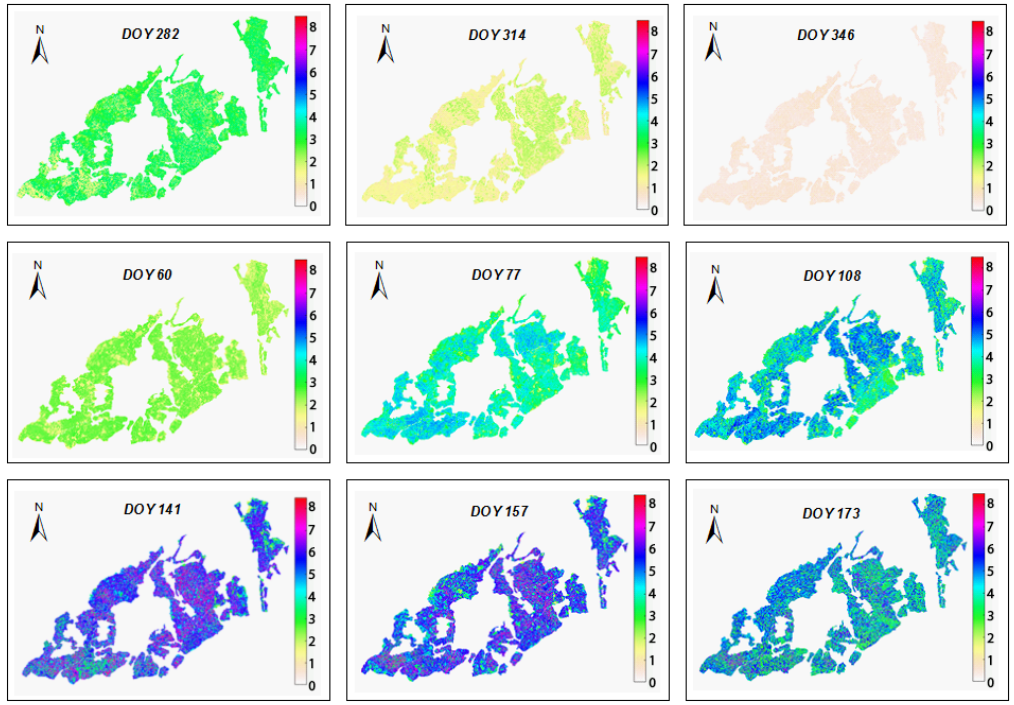
Figure 8. Doukkala irrigation scheme: actual daily evapotranspiration ET a estimated by applying SEBAL to multispectral L8/OLI, TIRS image data in the dry year 2015–2016.